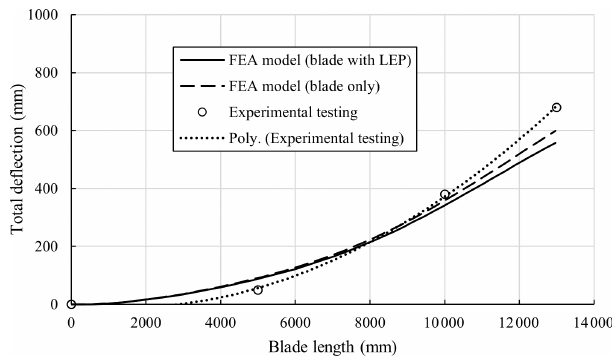
Figure 12. Comparison of the deflections from the FEA model of the full-scale wind turbine blade under the defined loading along the length of the blade with and without the LEP bonded and the experimental results (Fagan et al.,